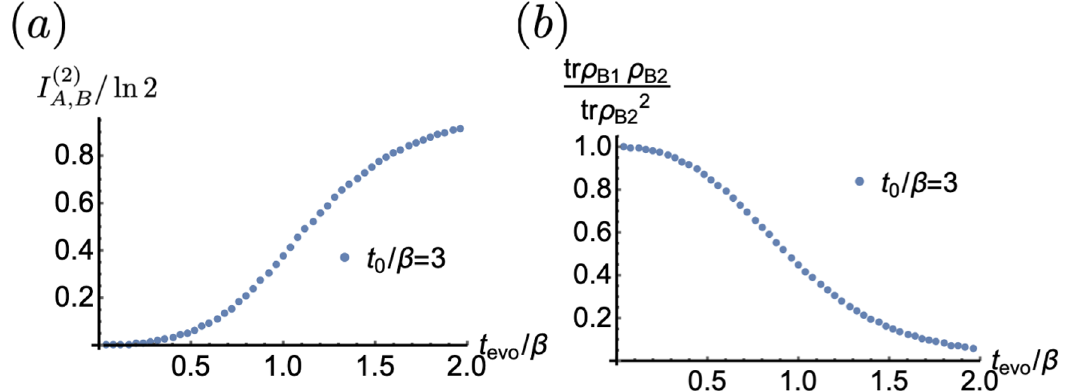
Figure 11. Numerical results of the mutual information and the overlap (blue dots), with V 2 =J = 0 : 05, (cid:12)J = 4 ; (cid:3) = 5 J for a late perturbation at t 0 = 3 (cid:12) > t Page